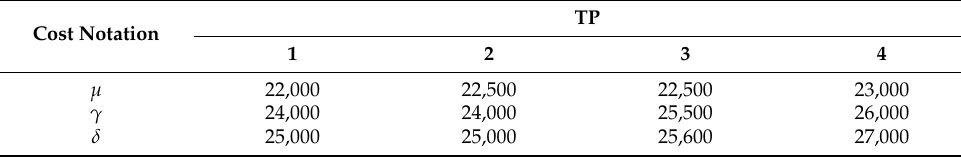
Table 3. Costs for workers (IDR